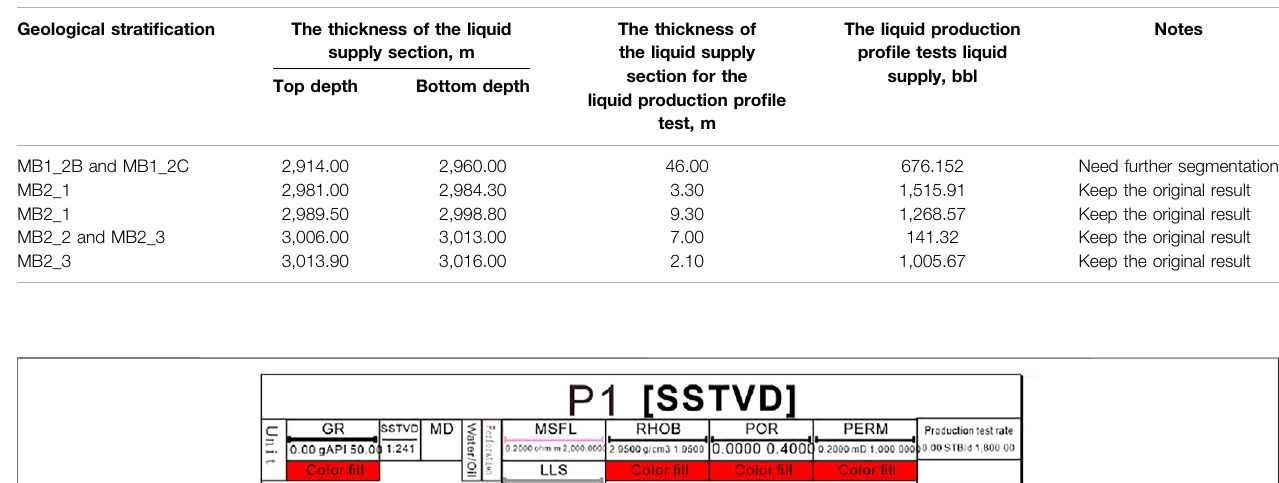
Frontiers in Energy Research |